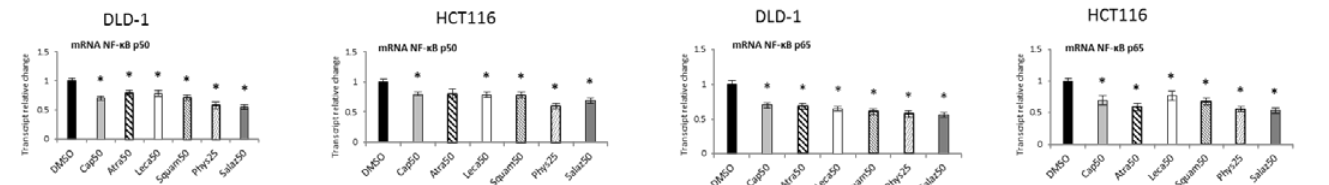
Figure 7. The effect of lichen-derived compounds on the expression of NF- κ B p50 and p65 in DLD-1 and HCT116 cells. The values (fold of control) are presented as the means ± SEM from three separate experiments. Asterisks (*) denote statistically significant changes from the control group ( p ≤ 0.05). DMSO , vehicle control; Cap50 , caperatic acid (50 µ M); Atra50 , atranorin (50 µ M); Leca50 , lecanoric acid (50 µ M); Squam50 , squamatic acid (50 µ M); Phys25 , physodic acid (25 µ M); Salaz50 , salazinic acid (50 µ M).